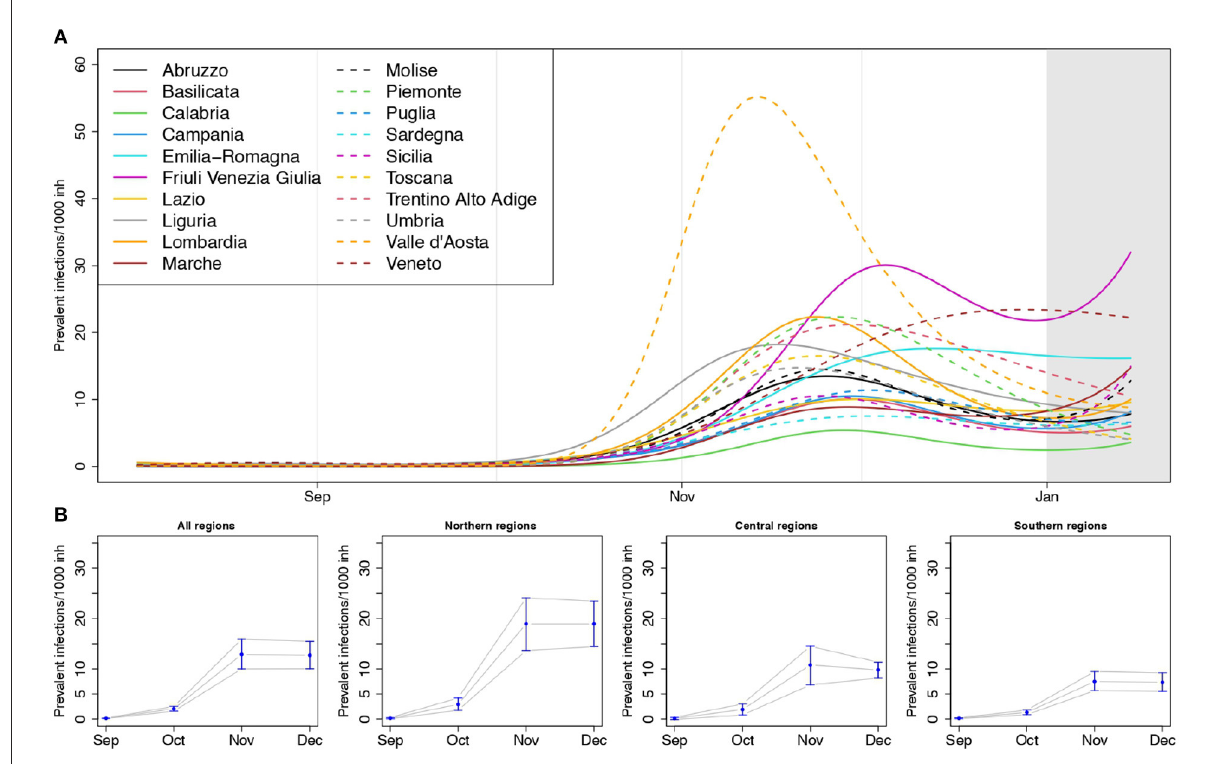
FIGURE3 (A) Estimated prevalence of infections (number of circulating infections over 1,000 inhabitants) by region, and (B) posterior mean of the meta-analytic monthly-average prevalences, for the entire country and by geographical areas, with 90% credible intervals (lower panel); p = 1.15 % , T = 14 days.